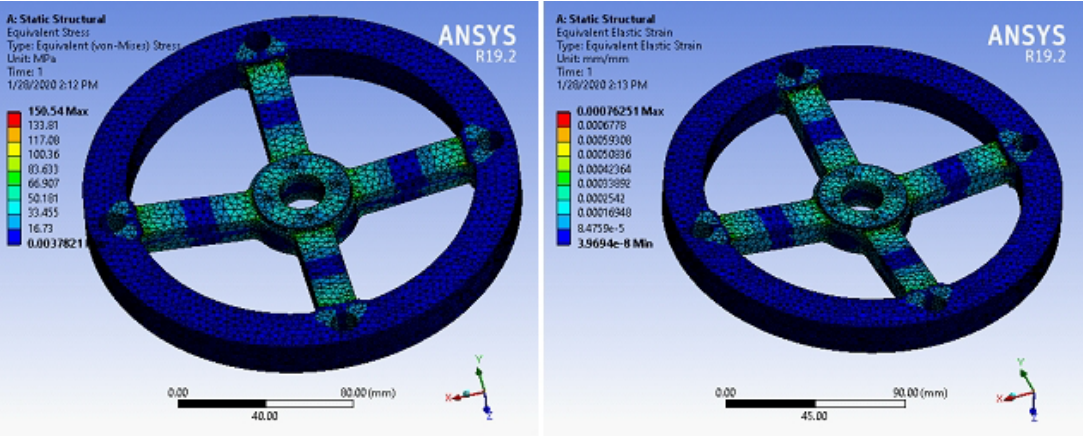
Figure 9. Equivalent mechanical stresses and elastic strain.